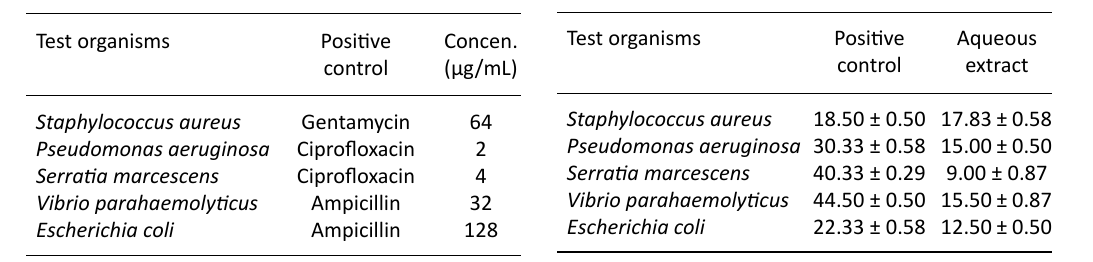
table 3. Cytotoxicity (% inhibition) of the crude extract Fusarium oxysporum Cancer cell lines